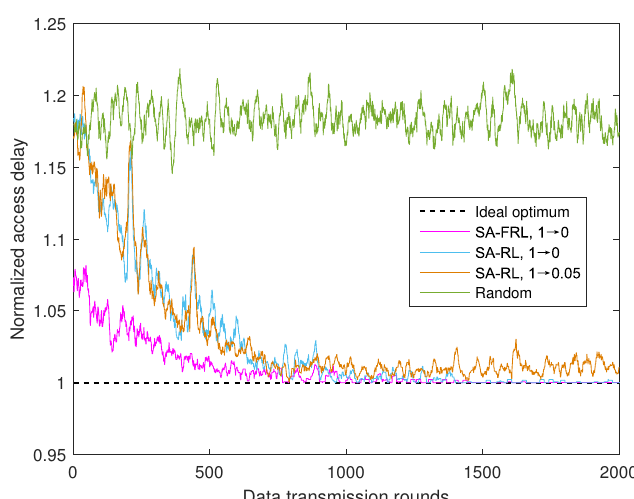
Figure 10. Performance convergence of access